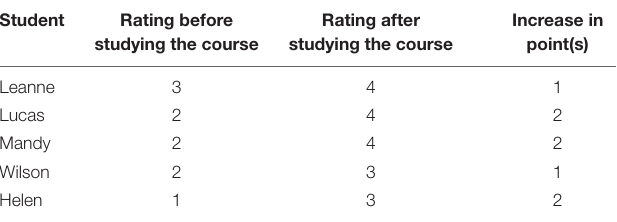
TABLE 2 | Understanding of STEM education of the interviewees before and after the course. Student